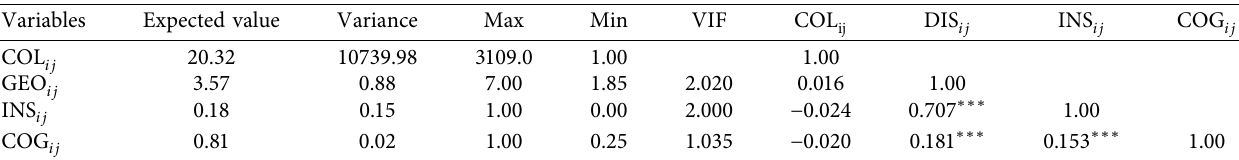
Figure 4: Hierarchical spatial distribution of China’s cities. Table 3: Descriptive statistical and correlation coefficient matrix of variables ( N �